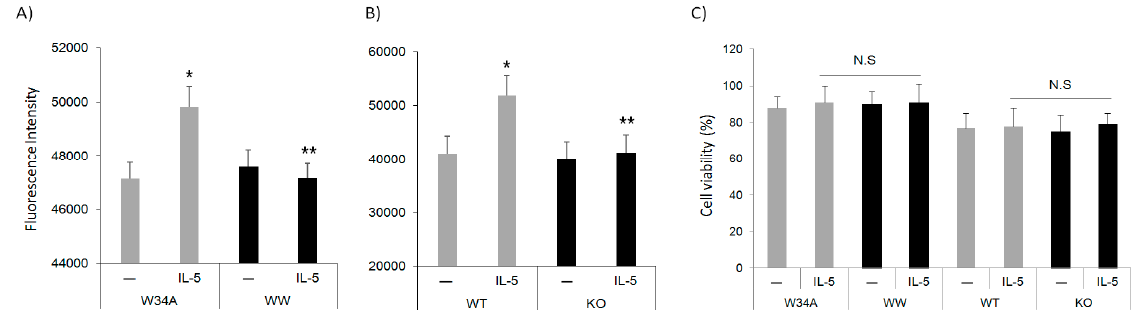
Figure 3. Pin1 is required for IL-5-induced cell migration. ( A ) Human peripheral blood Eos were starved and incubated with TAT-WW (100 nM) or control peptides (TAT-W34A) for 1 h before transmigration for 18 h towards hIL-5 (50 ng/mL). ( B ) BM-derived mouse Eos were starved (3 h) before migration for 18 h toward mIL-5 (50 ng/mL) and mEotaxin (20 nM) in the conditional medium. Migrated cells were quantitated by staining with DNA dye. ( C ) Cells were treated as in ( A ) and ( B ), and viability was determined using the trypan blue exclusion method after 18 h incubation. N.S: no significant. Data are from three independent experiments. * p < 0.05 between untreated (–) and IL-5 in W34A-treated cells, ** p < 0.05 between IL-5 treatments.